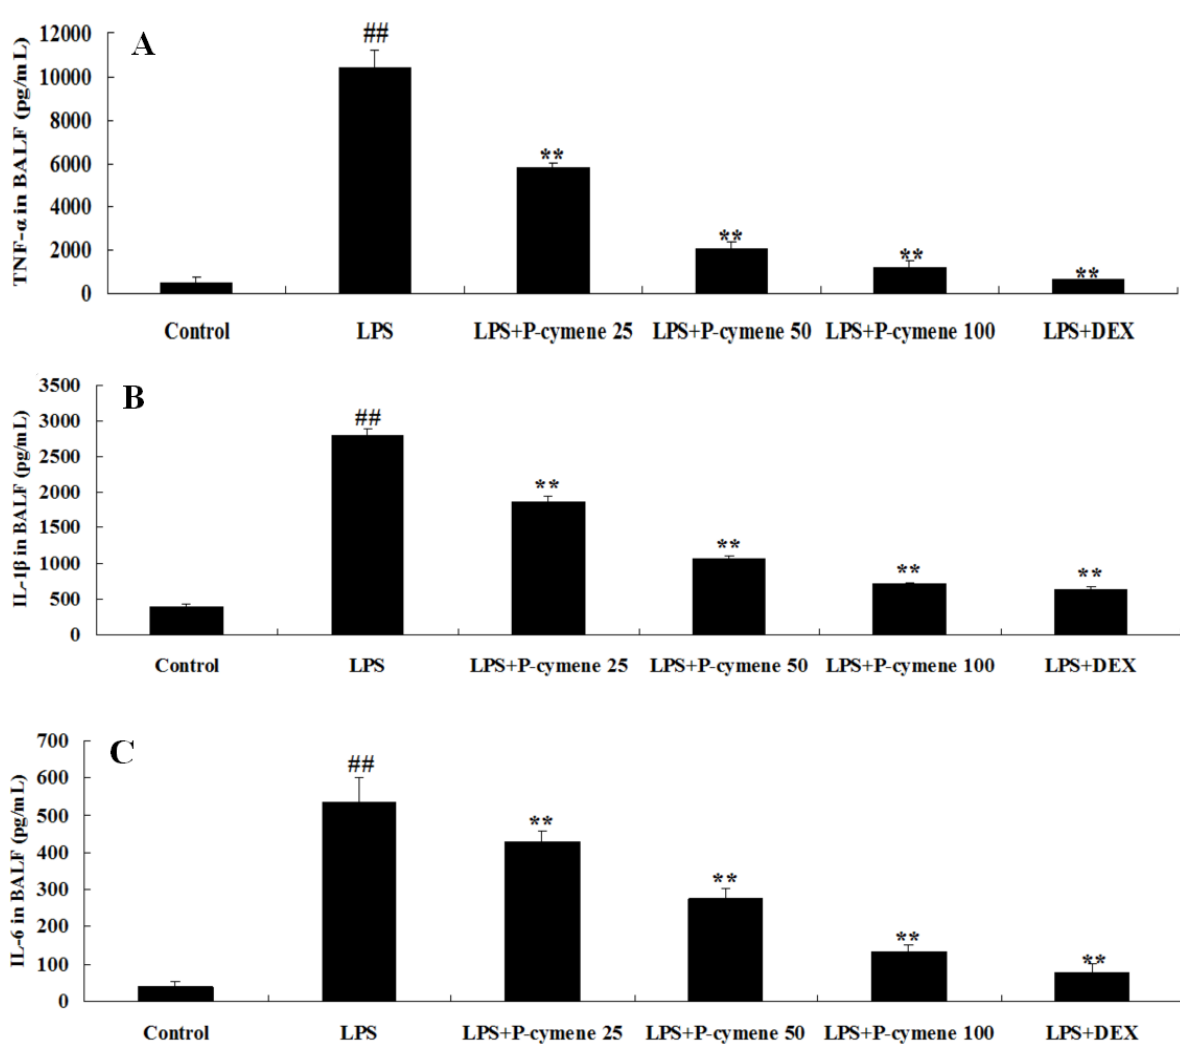
Figure 4. Effects of p -cymene on the production of in fl ammatory cytokine TNF- α , IL-1 β and IL-6 in the BALF of mice with LPS-induced ALI. Mice were given an intraperitoneal injection of p -cymene (25, 50 or 100 mg/kg) 1 h prior to administration of LPS. BALF was collected at 7 h following LPS challenge to analyze the in fl ammatory cytokines TNF- α ( A ), IL-1 β ( B ) and IL-6 ( C ). The values presented are the mean ± SEM (n = 6 in each group). ## p < 0.01 vs. control group, * p < 0.05, ** p < 0.01 vs. LPS